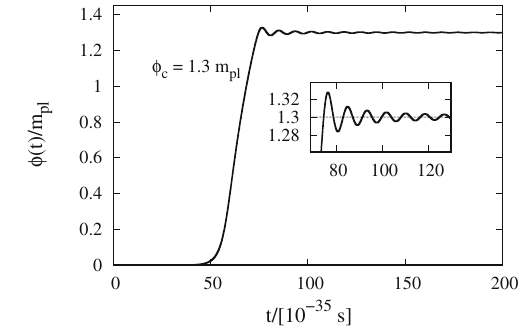
Fig. 1 Evolution of φ( t ) during and after inflation. The inset graphic shows in detail the first oscillations of the field